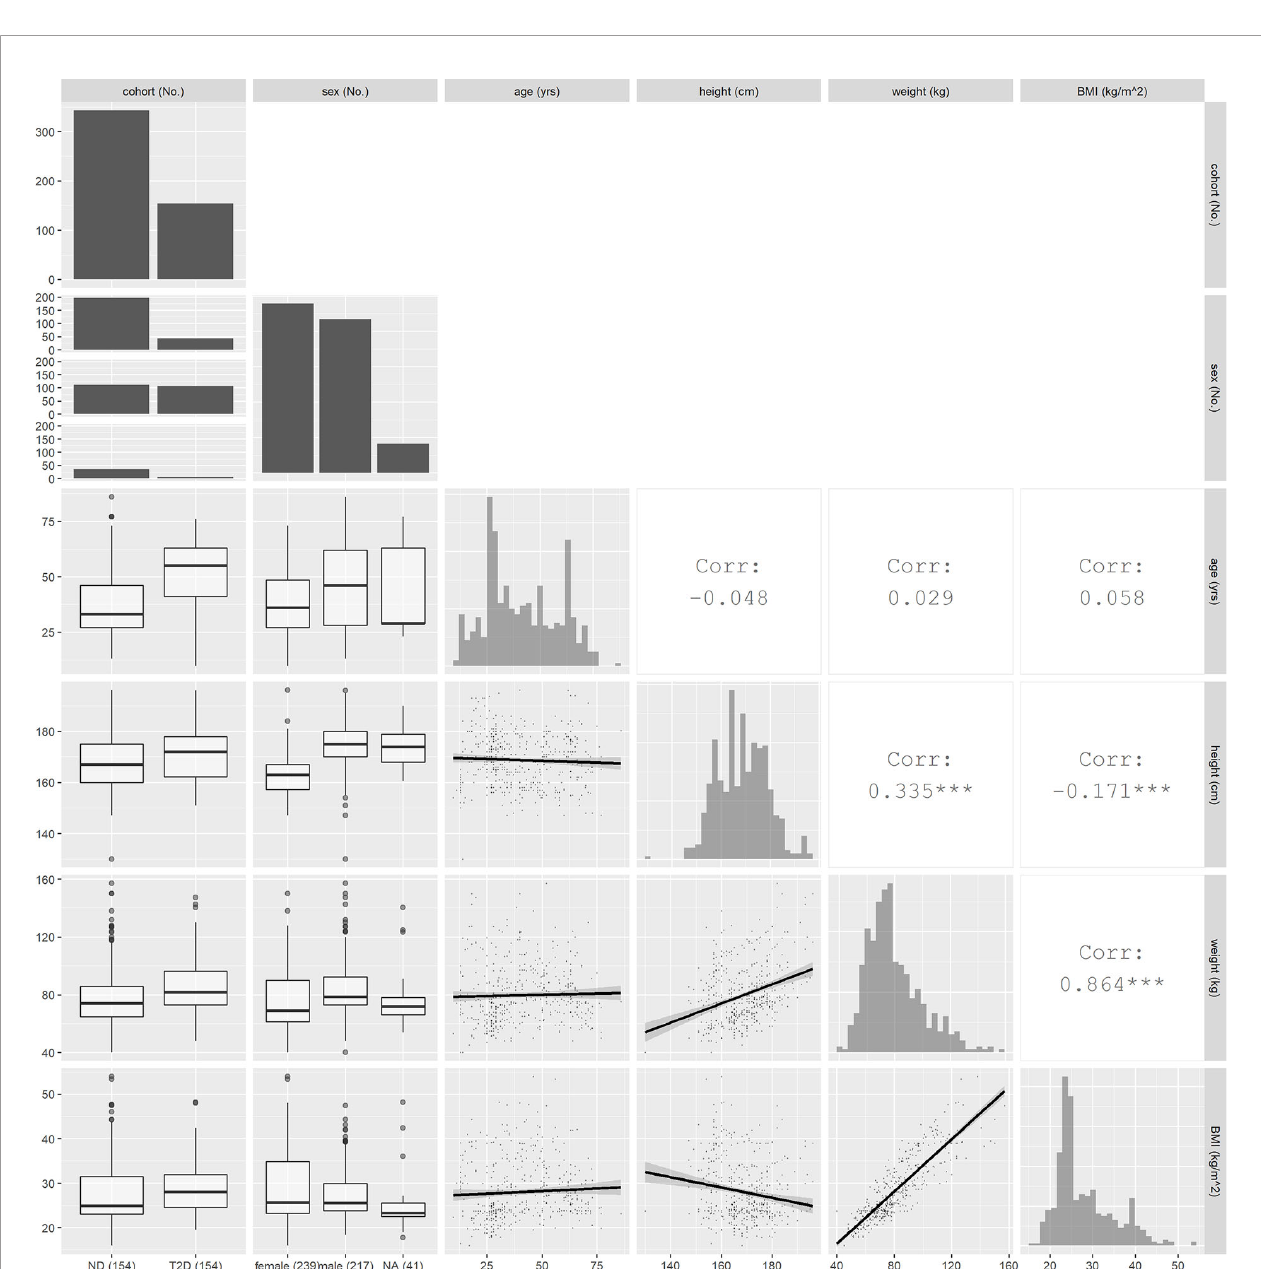
FIGURE 1 | Overview of covariate values and relationships. Histograms plots for continuous covariates and bar graphs for discrete covariates are shown on the diagonal. In the lower triangle, the boxplots between continuous and discrete covariates and scatter plots between continuous covariates are displayed. In the upper triangle, the correlation coef fi cients between continuous covariates are